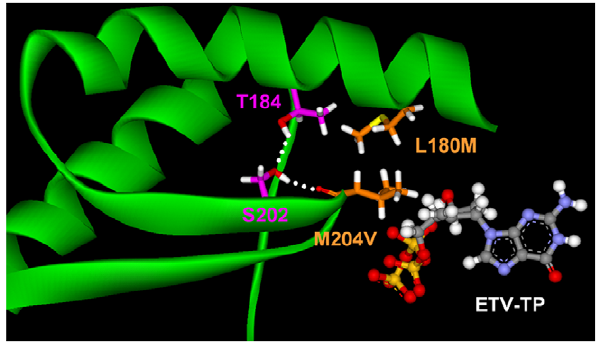
Figure 3. The T184-S202-204 hydrogen bonding network stabilizes the YMDD loop. The YMDD loop is shown with residues M204V + L180M and the H-bonding between residues T184, S202 and M204V are shown as dotted white